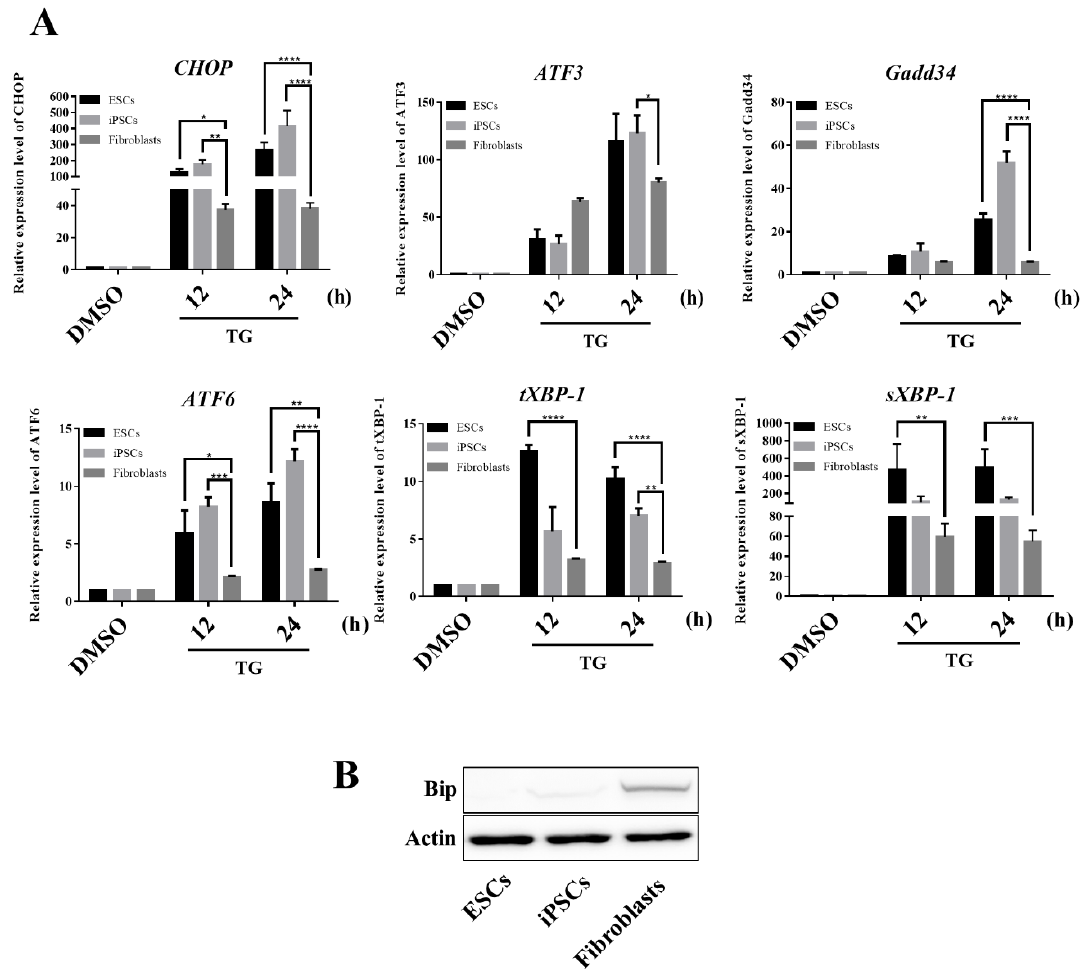
Figure 5. UPR induction is more significantly activated in hPSCs. ( A ) Expression levels of ER stress-associated genes in hESCs, hiPSCs, and fibroblasts during the 12- and the 24-h TG treatments. Values represent the mean ± SD. Tukey’s t -test: * p < 0.05; ** p < 0.01; *** p < 0.001; or **** p < 0.00001. ( B ) Expression levels of BiP and actin in ESCs, iPSCs, and fibroblasts were assessed by western blotting using specific antibodies ( n = 3).